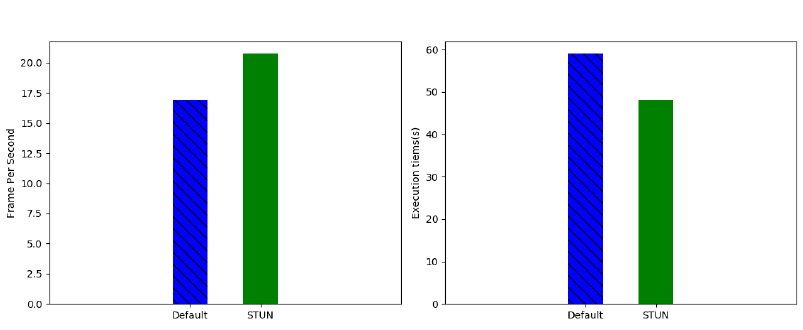
Figure 8. Performance comparison of face detection program using STUN.